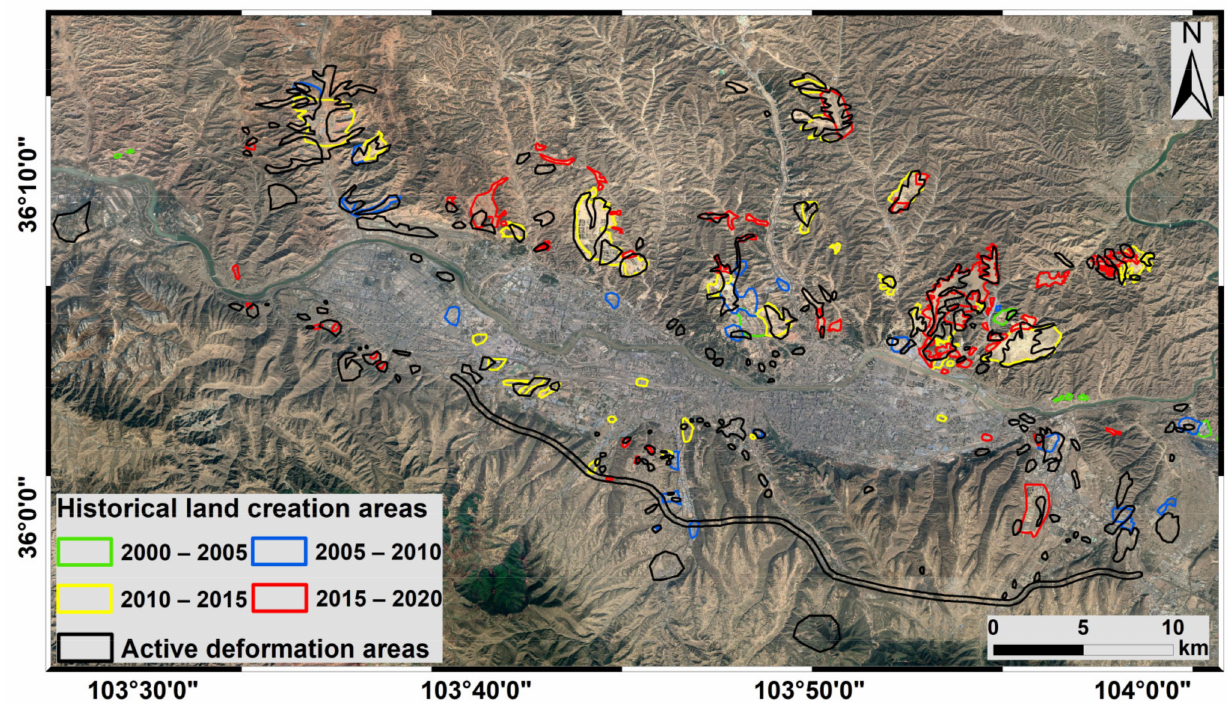
Figure 16. Correlation between active displacement areas and historical MECC areas in Lanzhou. Black polygons delineate active displacement areas in Lanzhou detected by InSAR-derived displacement